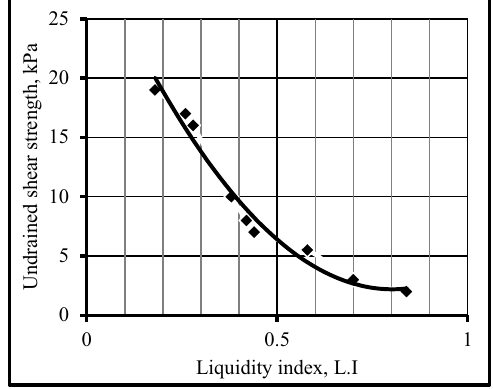
Figure 2: Variation in the undrained shear strength with liquidity index for the remolded clay after 48